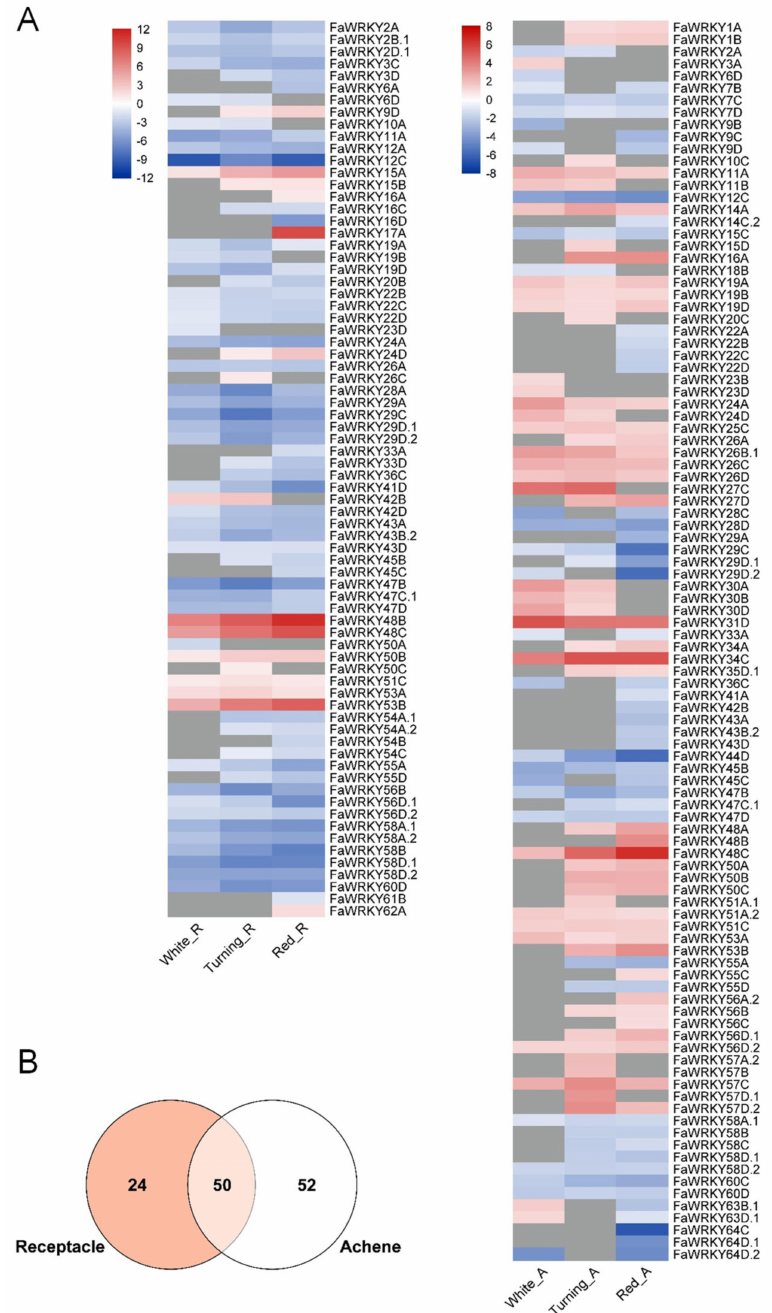
Figure 9. ( A ) Heatmap of differentially expressed FaWRKY genes during strawberry fruit ripening stages in receptacle (White_R, Turning_R, and Red_R; left side) and achene (White_A, Turning_A, and Red_A; right side) tissues. Changes in gene expression, with respect to green fruit tissues, are represented as log2 fold change if absolute values were >1 (padj < 0.01), otherwise, they were colored in grey. ( B ) Venn diagram showing those genes which were differentially expressed in receptacle and achene only, or in